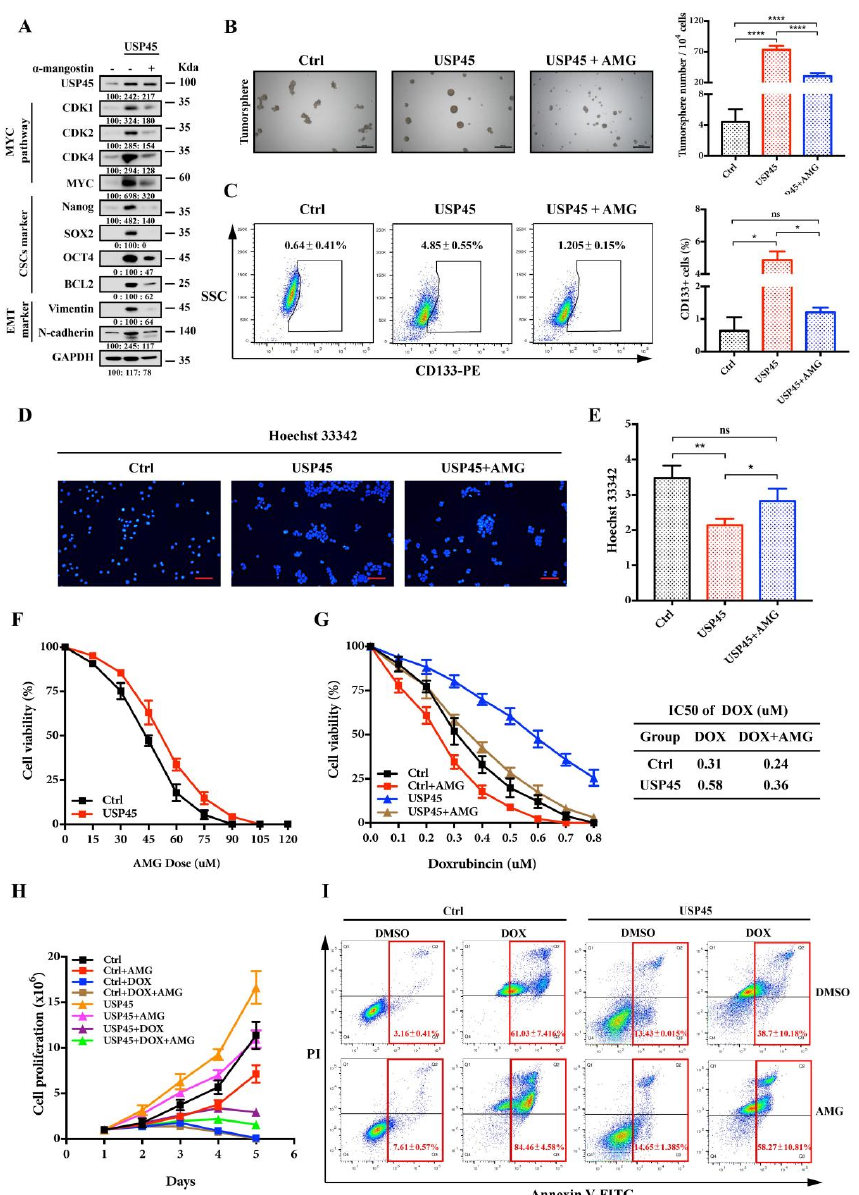
Figure 6. Alpha-mangostin inhibits USP45-induced cervical cancer stemness and drug resistance. ( A - D ) SiHa cells stably expressing USP45 were treated with 30 µM α -mangostin (AMG), and cells were collected and subjected to ( A ) Western Blot analysis, ( B ) tumorsphere formation assay, ( C ) FACS analyses for CD133-stained cells and ( D , E ) Hoechst 33,342 stain analysis. ( F ) The SiHa cells were treated with increasing concentrations of AMG for 48 h, cells were subjected to MTT cell via- bility assay. ( G ) The SiHa cells were treated with increasing concentrations of DOX or its combina- tion with 30 µM AMG for 48 h, followed by the MTT cell viability analysis. ( H , I ) The SiHa cells were placed on culture plates and treated with 0.5 µM DOX alone, 30 µM AMG alone or their combina- tion, followed by ( H ) the cell proliferation assay and ( I ) the apoptosis assay with Annexin V/PI stain- ing. Respective images and quantitation were shown. Data from independent experiments in dupli- cates were presented as means ± SD: p > 0.05 (no significance/ns), * p < 0.05, ** p < 0.01, **** p <